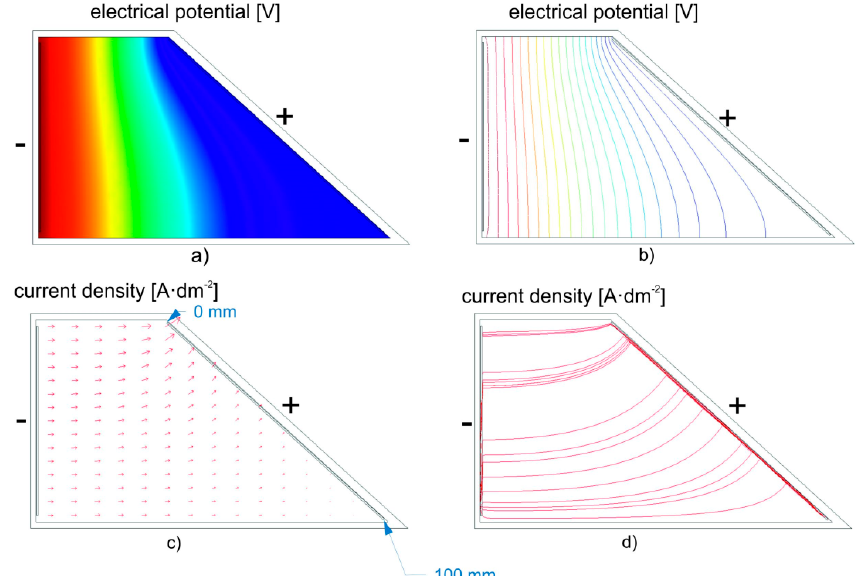
Figure 2. Simulation of electrical potential and current density distribution in experimental verification. ( a ) simulation of the electrical potential distribution in Hull’s tub; ( b ) simulation of the electrical potential distribution in Hull’s cavity; ( c ) simulation of the current density distribution in Hull’s tub; ( d ) simulation of the current density distribution in Hull’s tub.